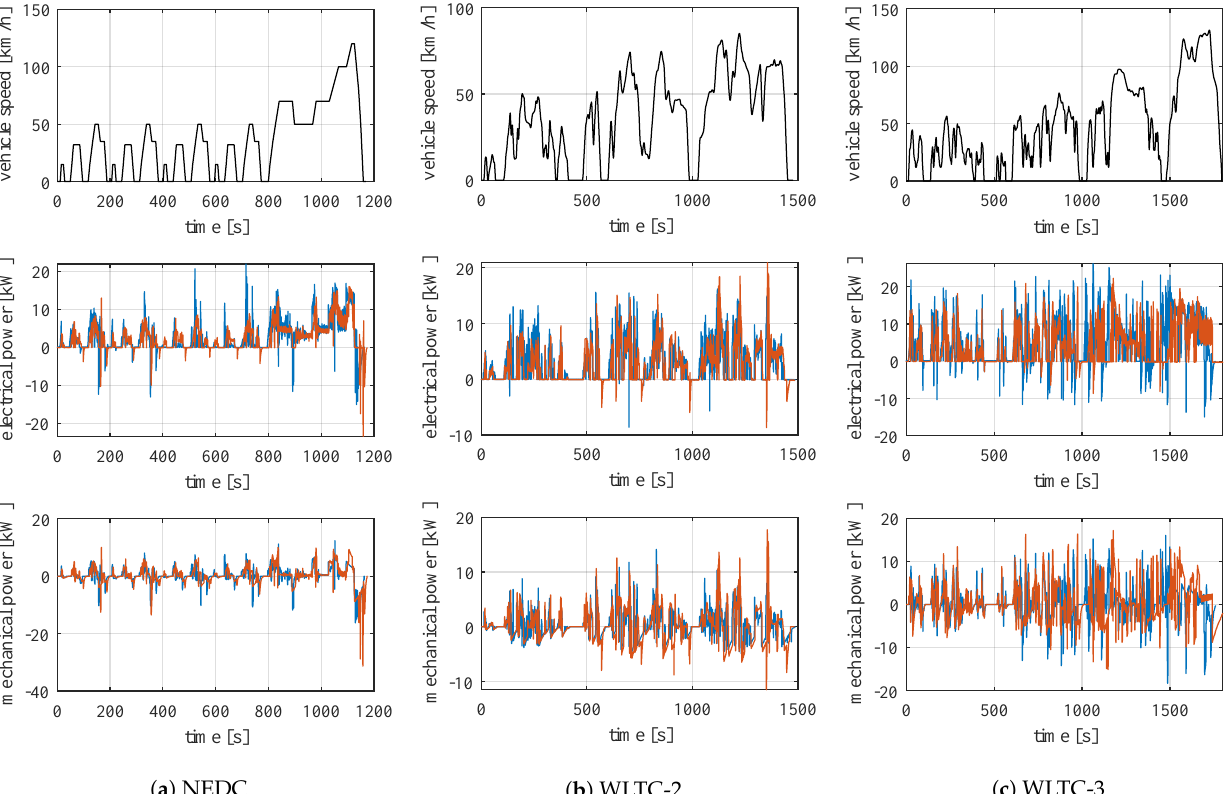
Figure 9. Electrical and mechanical power delivered by the battery and wheels, respectively, for NEDC, WLTC-2, and WLTC-3 driving cycles with final ratios of 4.3 (blue) and 3.54 (orange).